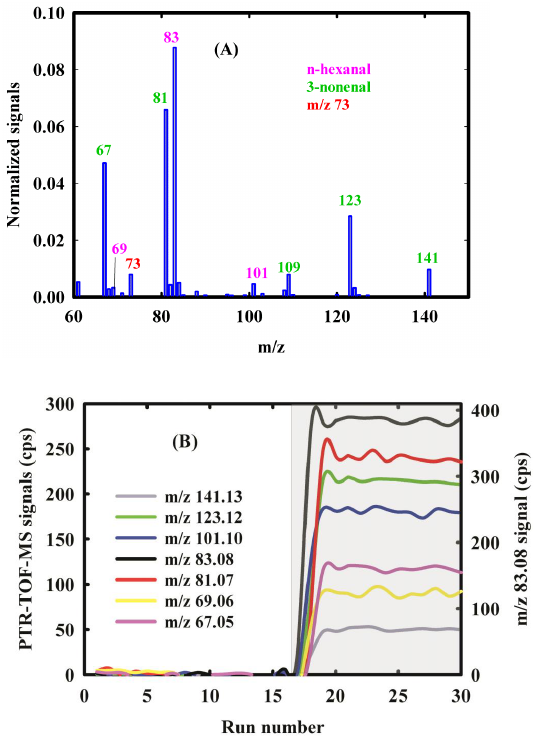
Fig. 2. Mass spectra for the gas-phase products from Type 1 experiments recorded by PTR-MS (A) and PTR-TOF-MS (B). In B, the shaded area represents exposure to 500 ppb O 3 .